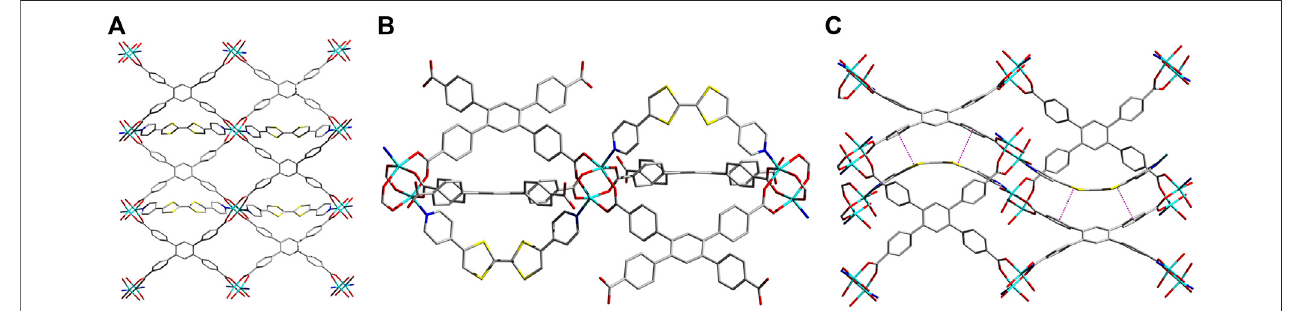
Frontiers in Chemistry |